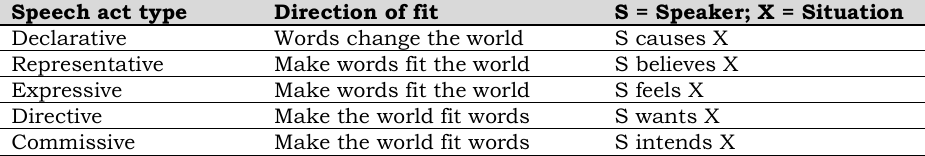
Table 2. The Searle’s taxonomy of speech acts